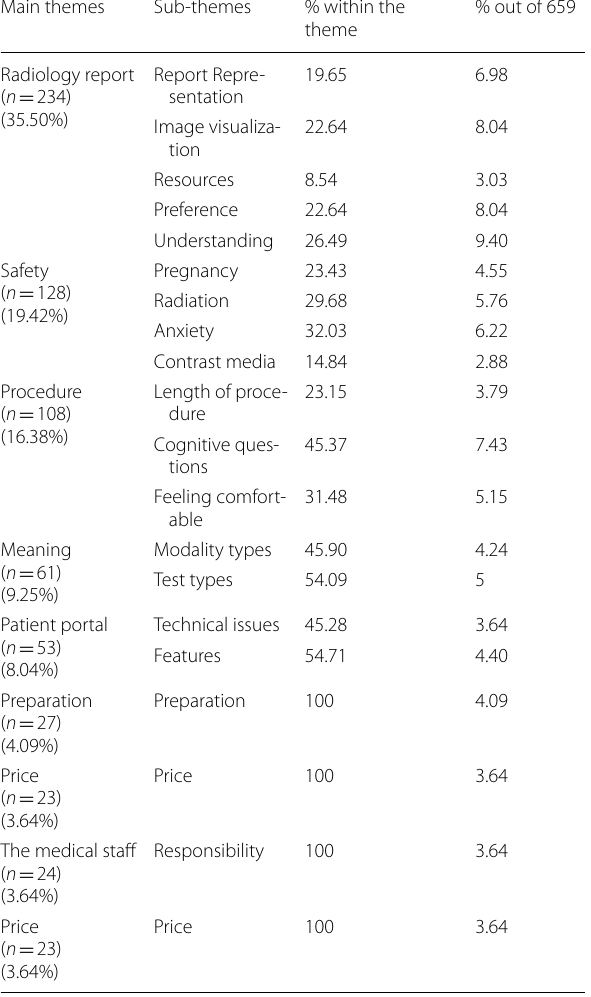
Table 1 The main themes that concern patients in radiology